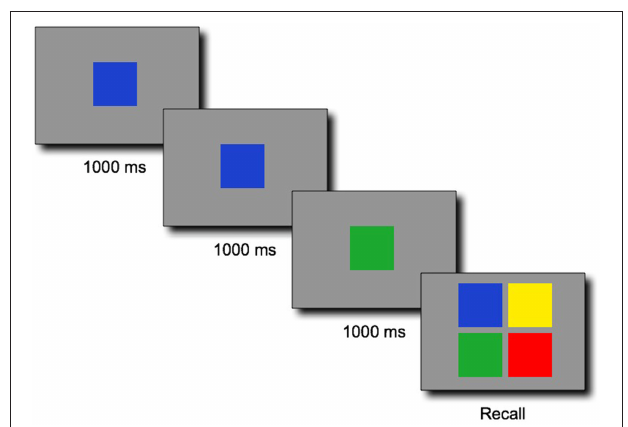
FIGURE 1 | Illustrative example of a sequence of three colors for the span task adapted from the SIMON r game, followed by a response screen in which the four colors were randomly placed on each of the four locations at each trial. The 1000-ms timing was in reality split between a 400-ms presentation of the color followed by an inter-stimulus interval of 600 ms during which a blank gray screen was displayed.